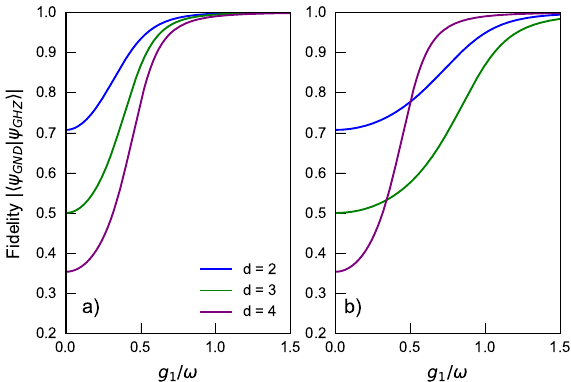
= g and different qudit sizes d = 2,3,4 1 2 = 0). Fidelity between the Hamiltonian ground state (obtained 1 = 0.15 ω , Ω = 0.1 ω , (b) Ω = 0.55 ω , Ω = 0.5 ω . 1 2 1 2